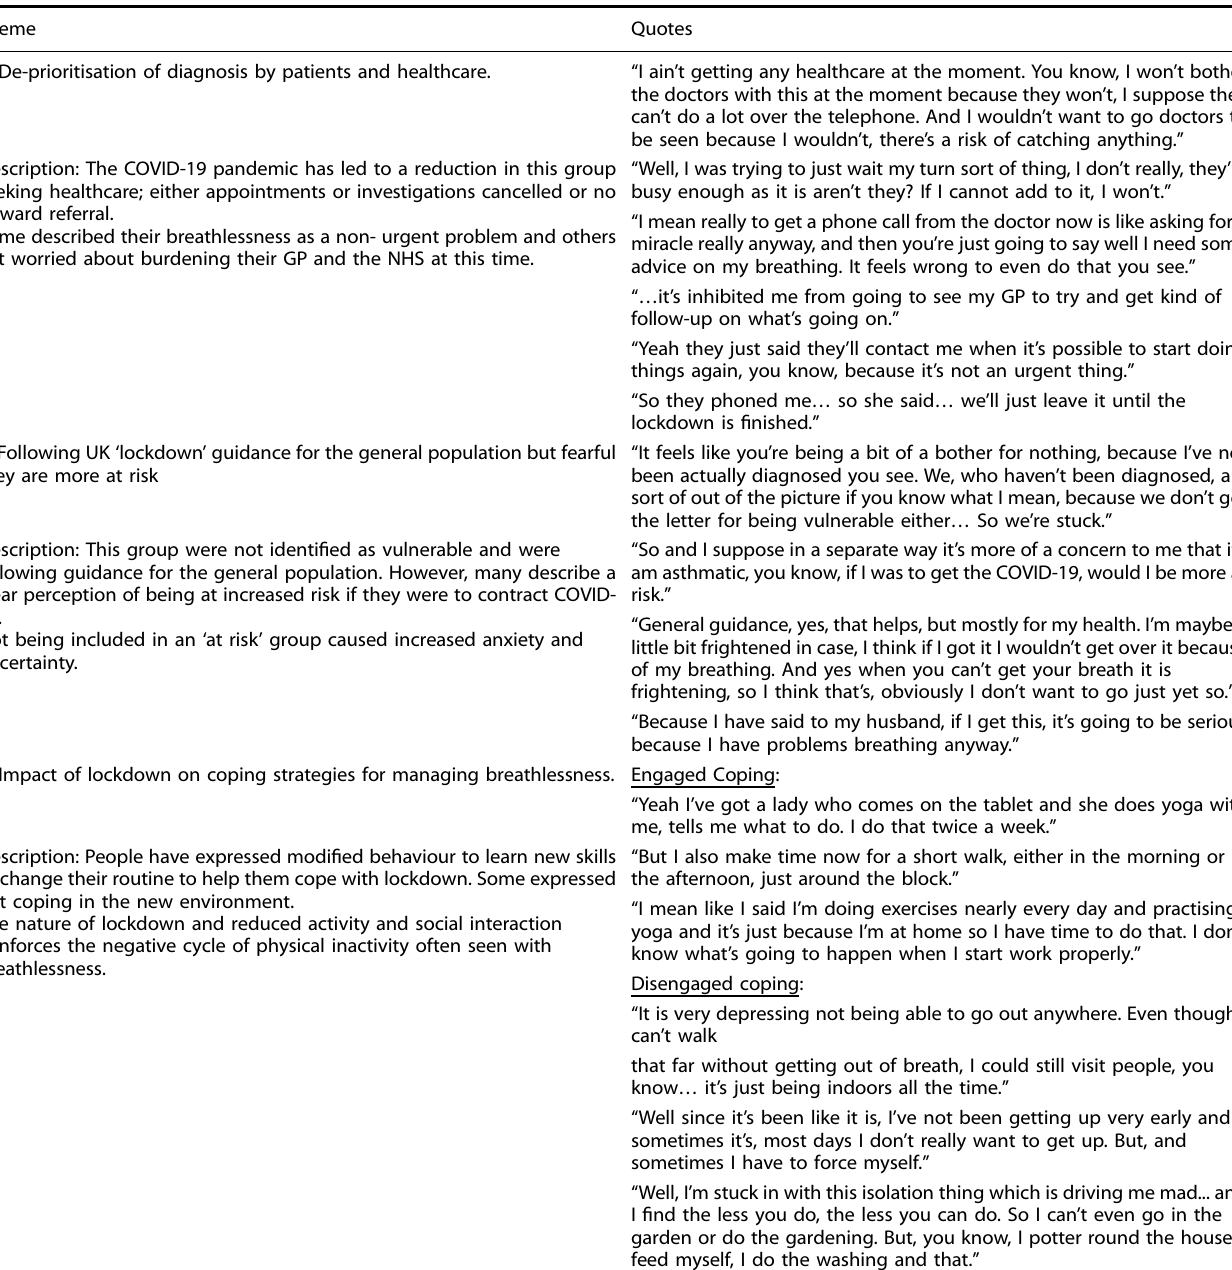
Table 1. Results: Themes, description and